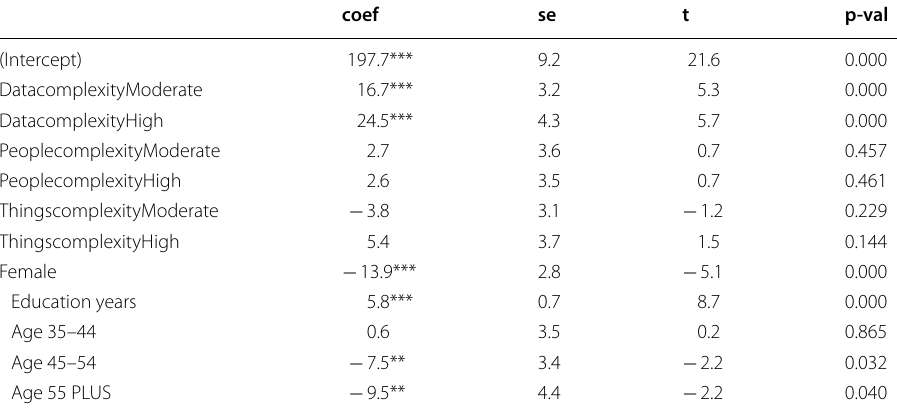
Table 23 Regression results for United Kingdom. Source: PIAAC 2012, DOT index, ISCO-08 codes